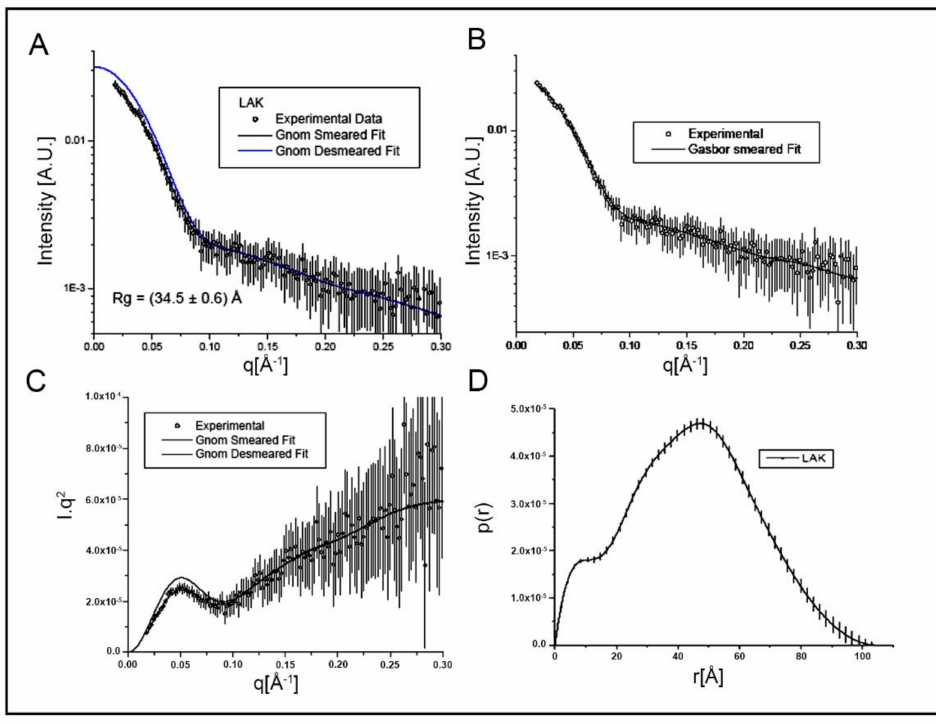
Figure 1. SAXS analysis of Lmr-47 structure, flexibility ( A – C ), and Kratky plot at pH 8.0 ( D ). Small- angle scattering pattern ( A – C ) and pair distribution function [p(r)] ( D ). The p(r) function and fitted curves were calculated from experimental scattering data using the program GNOM [15]. For details, see text. The curves for thermally denatured Lmr-47 (without enzymatic activity) at pH 8.0 are plotted for